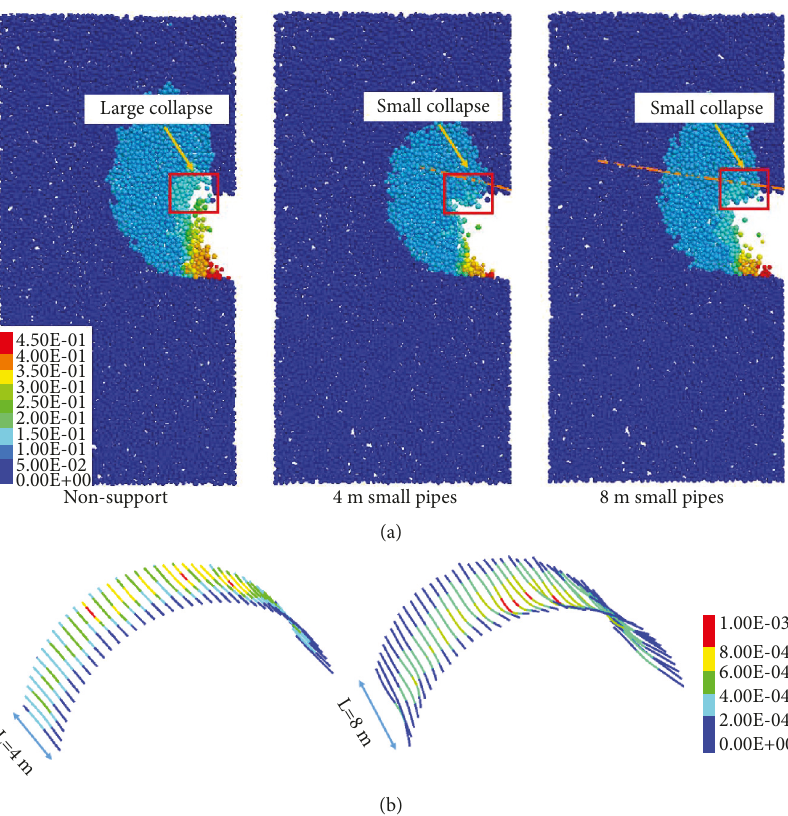
Figure 13: Support effect of the advanced small pipes: (a) displacement nephogram of the surrounding rock; (b) deformation diagram of the small pipes. Unit: